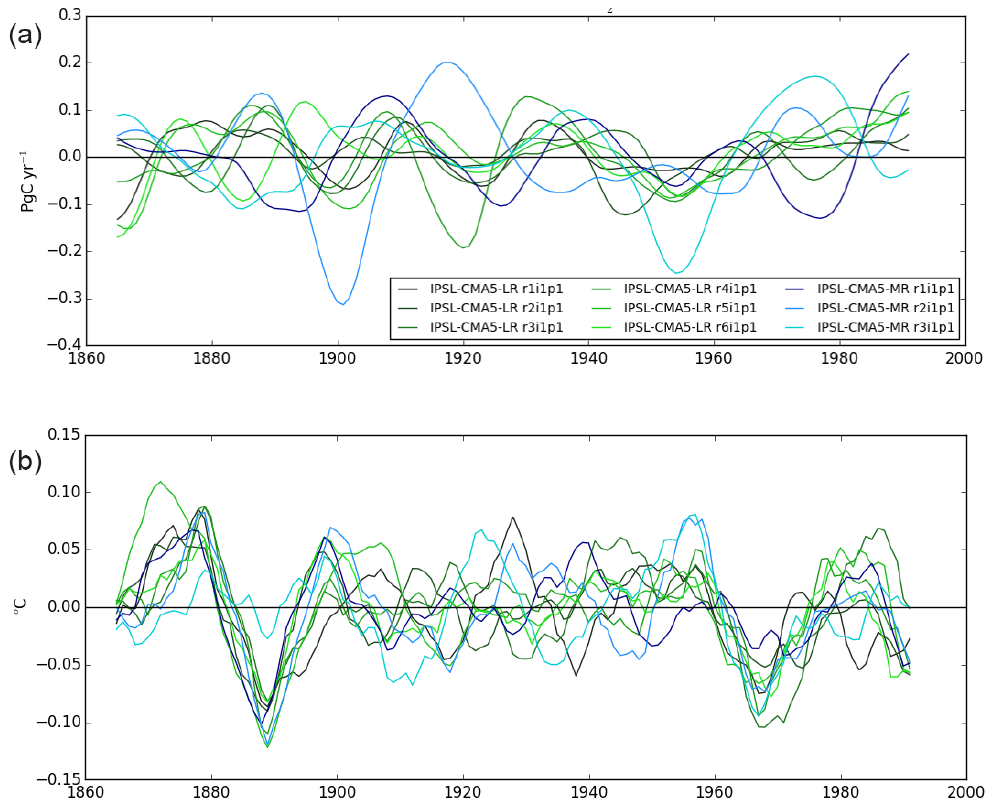
Figure 5. As in Figure 4 but for six different realizations from IPSL-CM5A-LR and three from IPSL-CM5A-MR (top panel) and the corresponding SST temperature anomalies in the Nino3.4 region. The SST anomaly is calculated as the 10-year moving average departure of the SST data from a 30-year-long reference